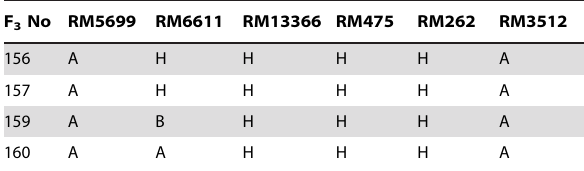
Table 2. Genotypes of four recombinant F 3 individuals for putative resistant starch sbe3-rs flanked by RM6611 and RM13366: A – ‘Miyang 23’, B – ‘Jiangtangdao 1’ and H –